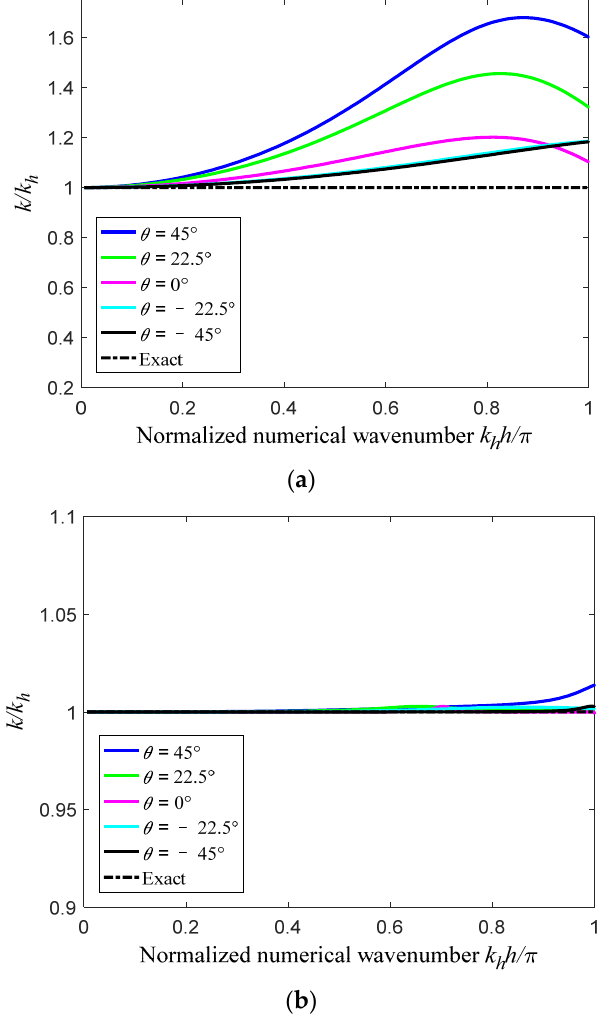
Figure 2. The properties of the spatial dispersion error in different wave propagation directions: ( a ) FEM; ( b ) EFEM.